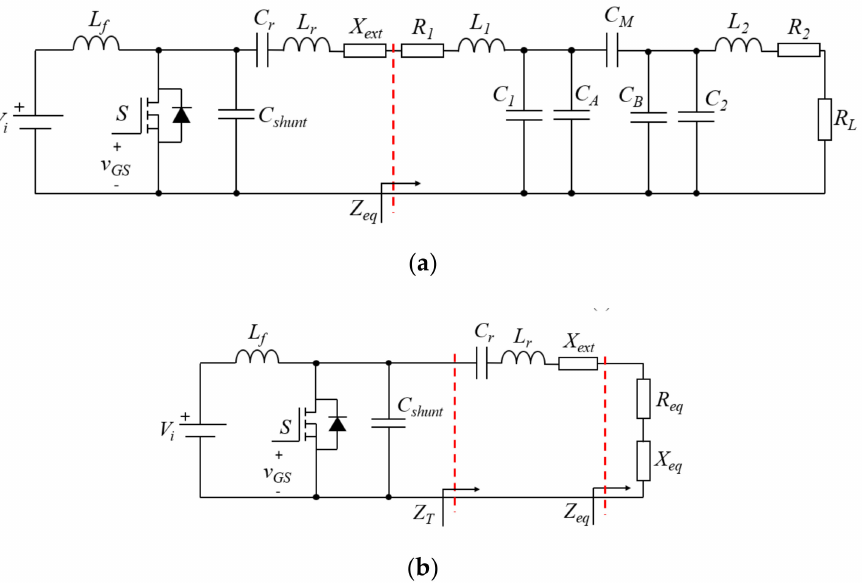
Figure 4. Circuit of capacitive wireless power transfer Class-E inverter. ( a ) Circuit topology. ( b ) Circuit topology with equivalent